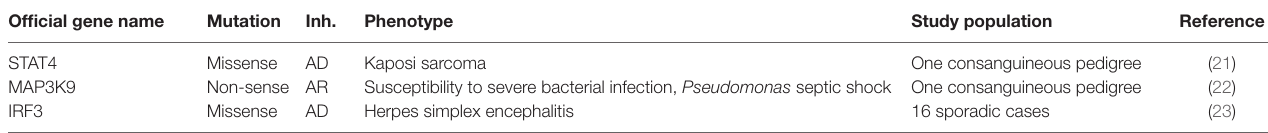
TaBle 1 | new PiD genes discovered since the latest report of iUis in 2015 till april